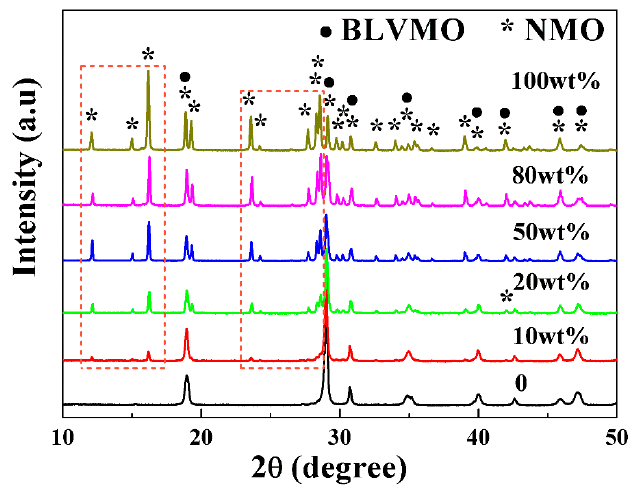
Figure 2. X-ray diffraction (XRD) patterns of (100 − x) wt.% BLVMO-x wt.% NMO ceramic composites.